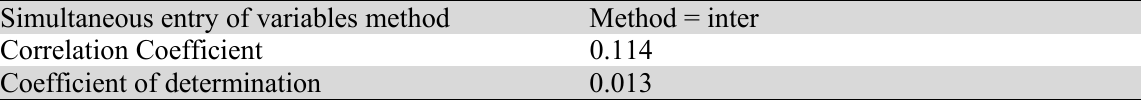
Correlation Coefficient between P/E ratio and stock returns Simultaneous entry of variables method Correlation